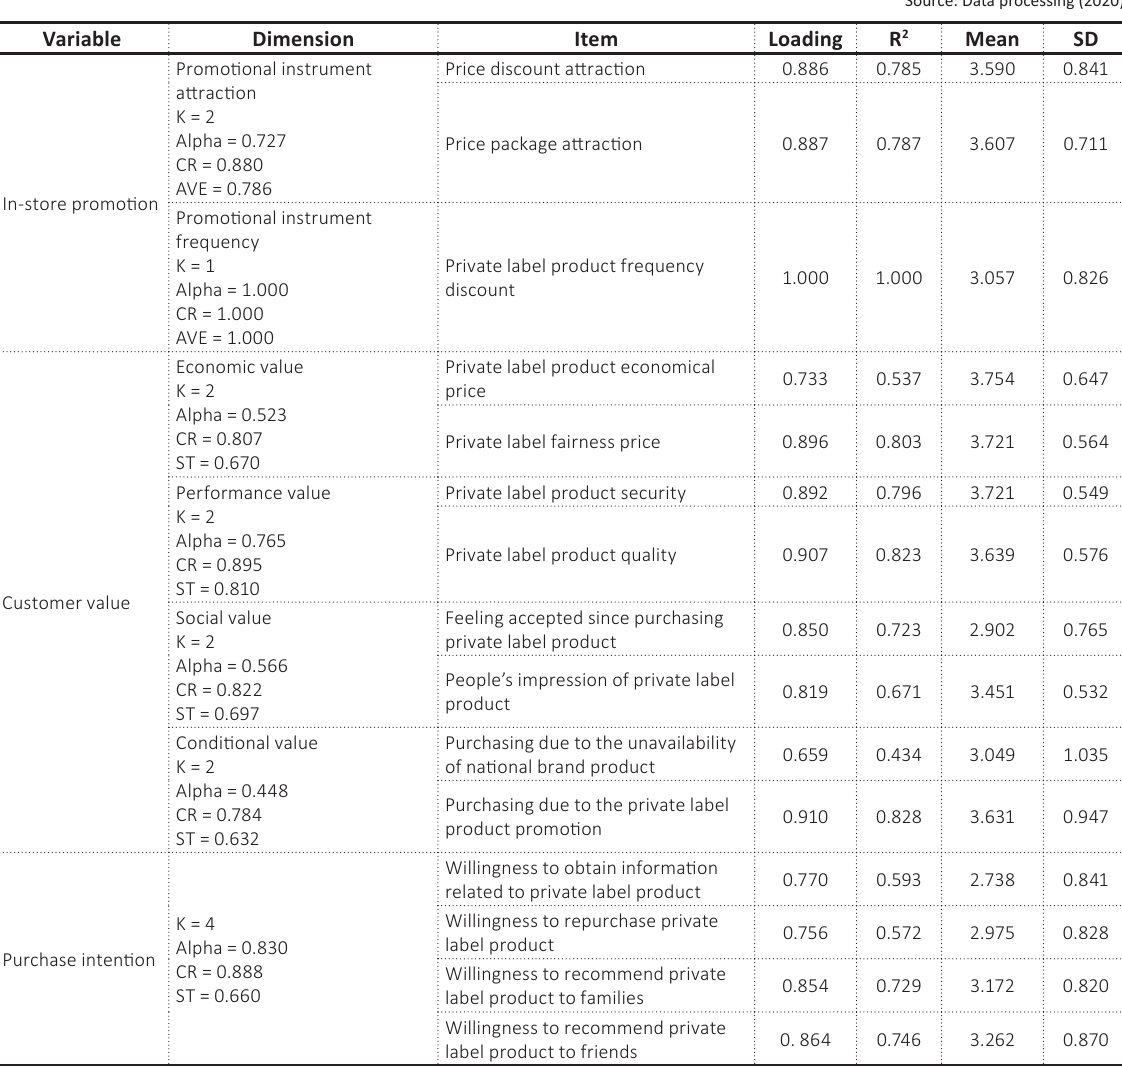
Table 2. First-order measurement